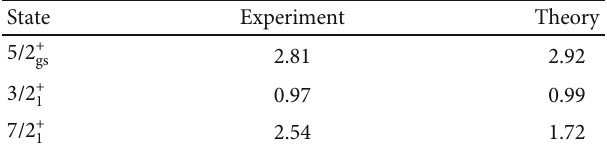
Table 3: Experimental [62] and calculated magnetic moments in ð N Þ . The magnetic moments are units of nuclear magneton μ B calculated using the standard g factors g = − 3 : 826 , g = 5 : 586 , s , n s , p = 0 , and g = 1 in nuclear magneton g l , n l , p